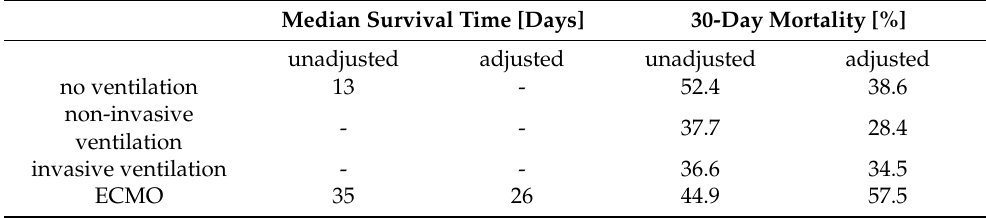
Figure 5. Association between ventilation regime and survival. ( A ): Unadjusted Kaplan–Meier analysis, ( B ): Forest plot depicting univariate Cox regression. ** p < 0.01, *** p < 0.001. Table 2. Median survival time and 30-day mortality by ventilation therapy received before and after adjustment for the confounding factors age, Charlson comorbidity index, and number of